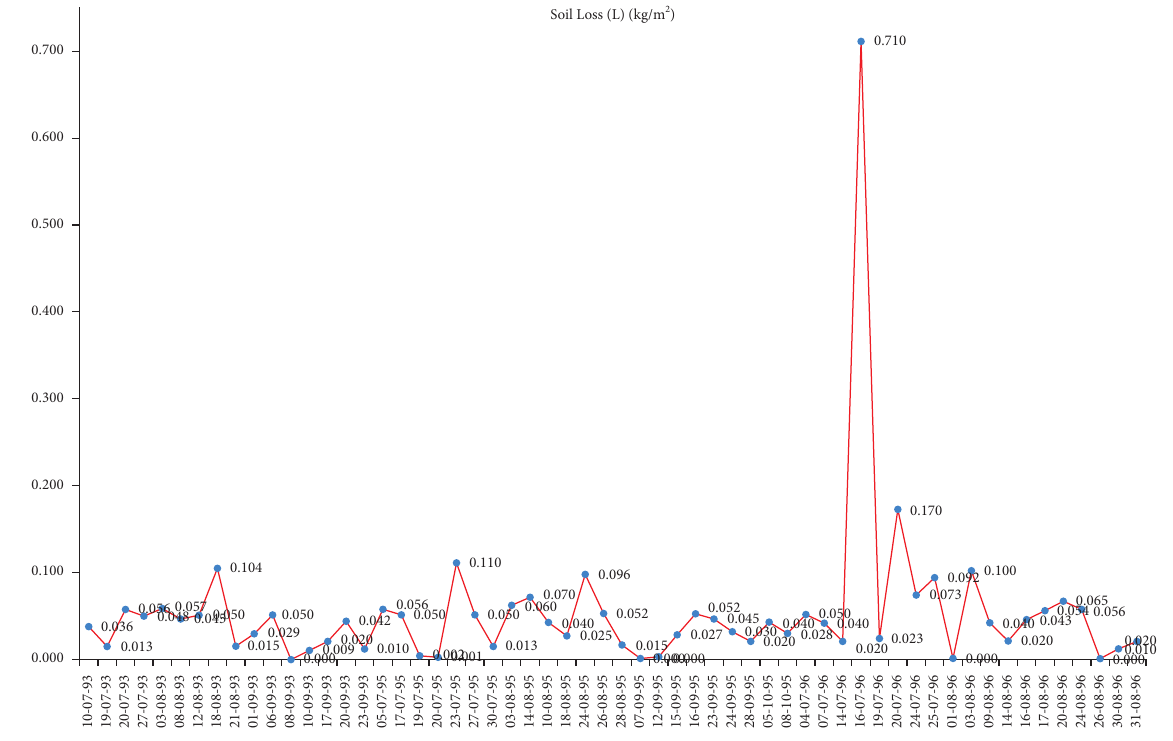
Figure 11: Observed soil loss with the selected dates of